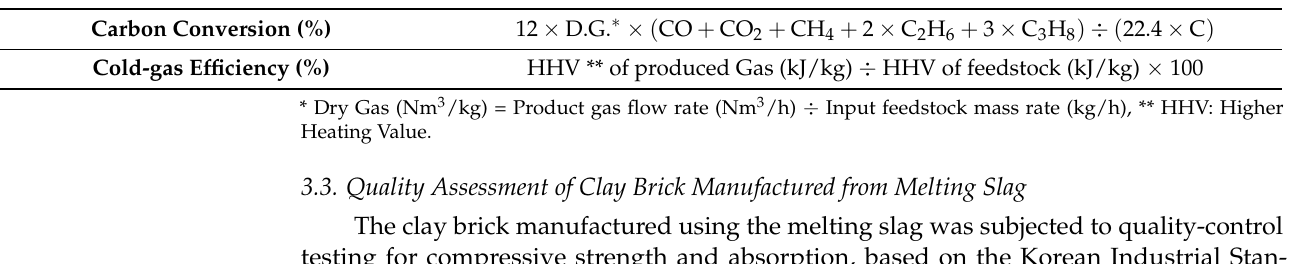
Figure 6. Assessment of ASR Gasification Efficiency. ( a ) Yields of Solid Residue and Dry Gas with Different Temperatures and ER, ( b ) Results of Carbon Conversion and Cold gas Efficiency with Different Temperatures and ER. Table 9. Equations of Carbon Conversion and Cold-gas Efficiency.